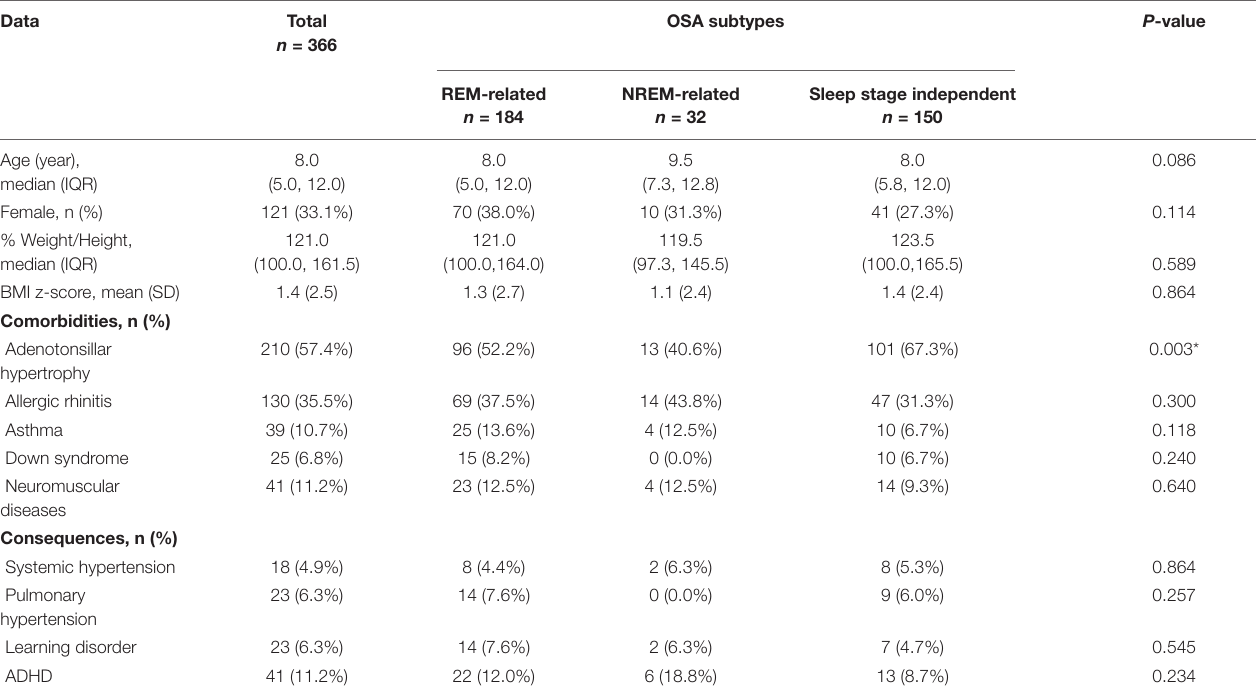
TABLE 1 | Demographic data of children with different OSA